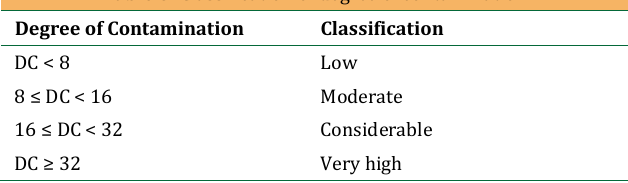
Table 5: Classification of degree of contamination